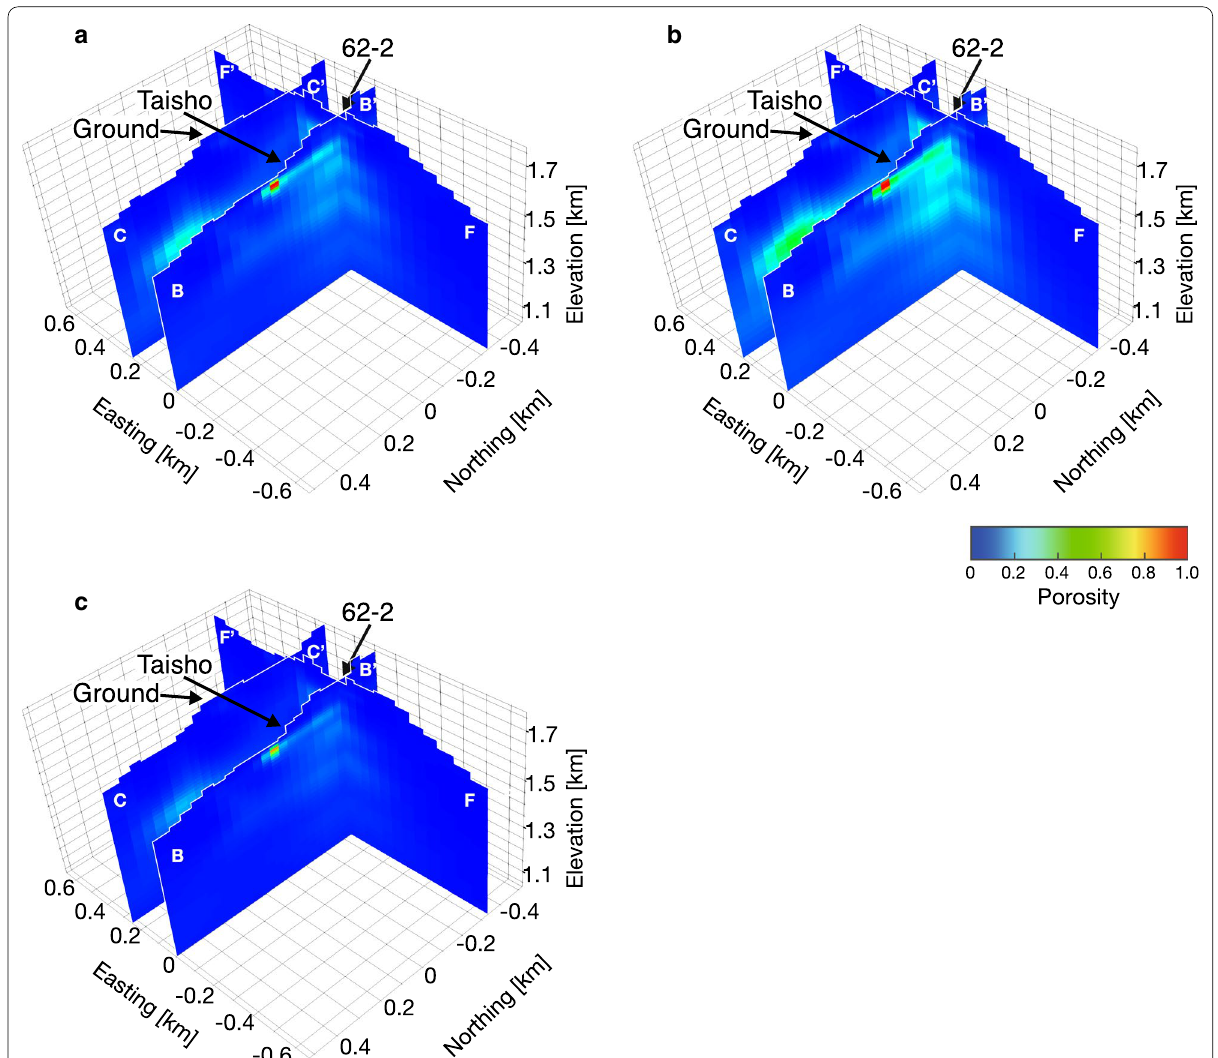
Fig. 5 Spatial visualization of the porosity beneath the active craters. a The porosity distribution calculated with the fluid resistivity 1.2 Ωm. b The porosity distribution calculated with the fluid resistivity 2.0 Ωm. c The porosity distribution calculated with the fluid resistivity 0.7